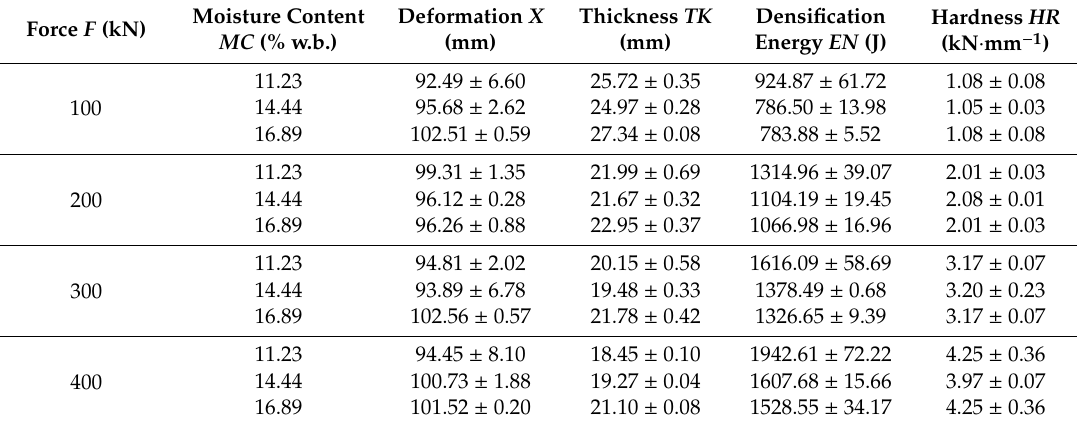
Table 2. Deformation, thickness, densification energy, and hardness of ground sunflower stalks with forces and moisture contents.